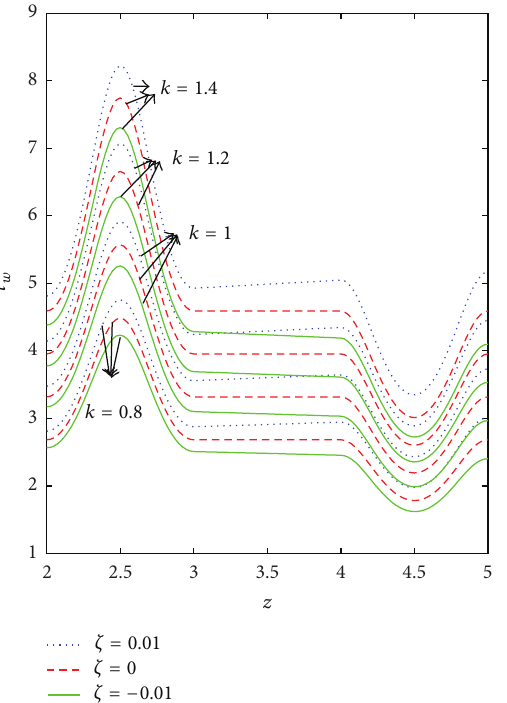
Figure 8: Axial variation of wall shear stress ( 𝜏 𝑤 ) for different values of 𝛿 by taking 𝑛 = 0.8 , 𝑘 = 1.4 , and 𝜏 𝑦 = 0.1 .